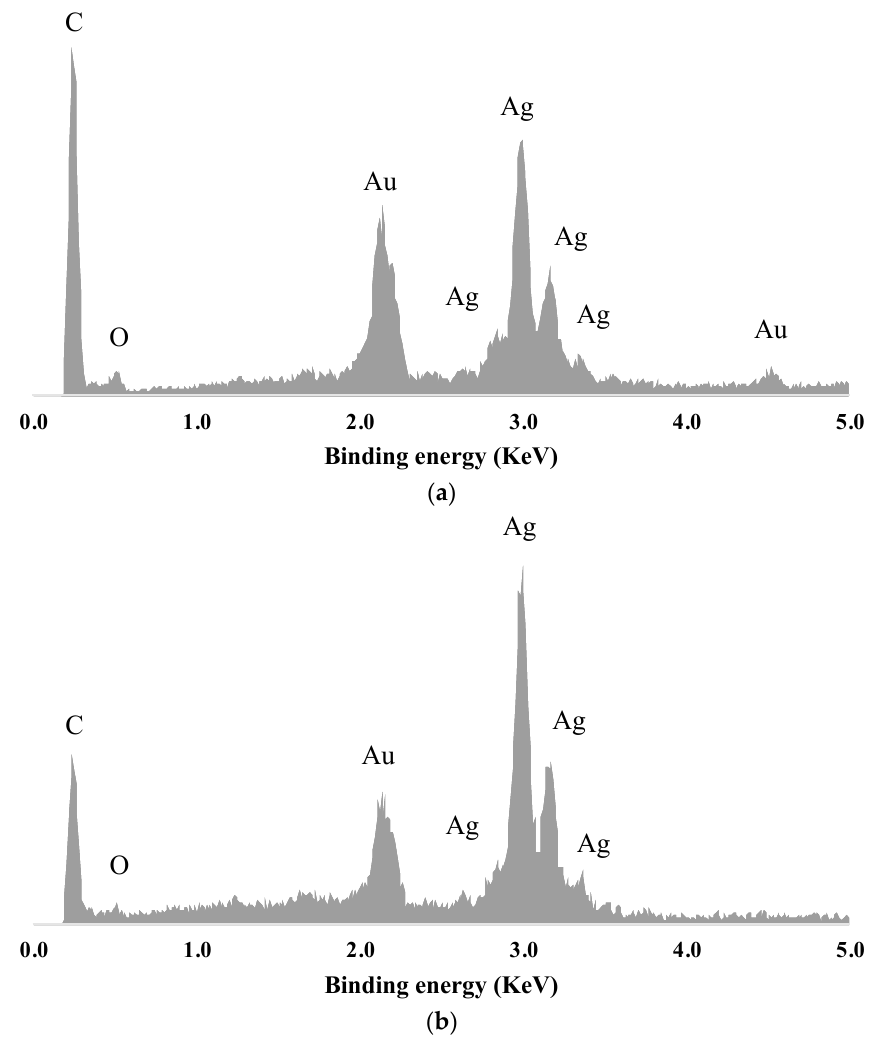
Figure 4. EDS analysis of the spray ( a ) and exhaustion at 30 °C ( b ) deposition methods for the PA66 samples with DBD plasma treatment.